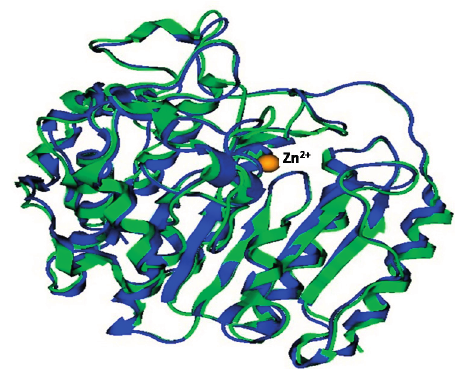
Figure 2. Cartoon representation of homologues superposition. Human histone deacetylase 2 (HDAC2) in blue, Plasmodium falciparum histone deacetylase1 ( Pf HDAC1) in green and zinc in